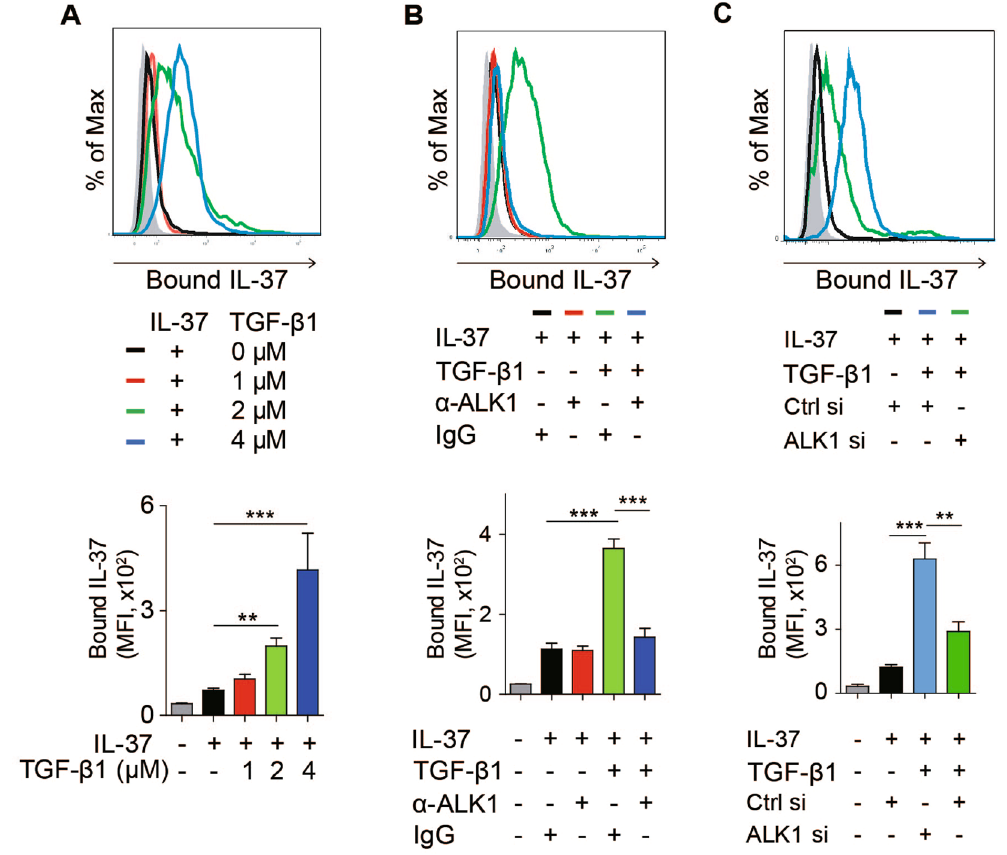
Figure 2. TGF- β 1 enhanced the binding of IL-37 to HUVECs. ( A ) TGF- β 1 facilitates the binding of IL-37 to HUVECs. HUVECs were incubated with 1 μ M biot-IL-37 with/without indicated concentrations of TGF- β 1. Bound biot-IL-37 was assessed by flow cytometry. Gray histograms indicated unlabeled cells. The mean fluorescence intensity (MFI) of bound IL-37 was quantified ( n = 4). ( B ) ALK-1 mediates TGF- β -facilitated binding of IL-37 to HUVECs. Flow cytometry of HUVECs incubated with indicated cytokines or antibodies. Biot-IL-37 and TGF- β 1 were used at 1 μ M. Anti-ALK1 antibody ( α -ALK1) and IgG were used at 10 μ g/mL. ( C ) Control and ALK1 siRNA-transfected HUVECs were incubated with indicated proteins or antibodies (10 μ g/mL). Biotinylated IL-37 (biot-IL-37) and recombinant TGF- β were used at 1 μ M. Data are presented as mean ± SEM. ** P < 0.01, *** P <